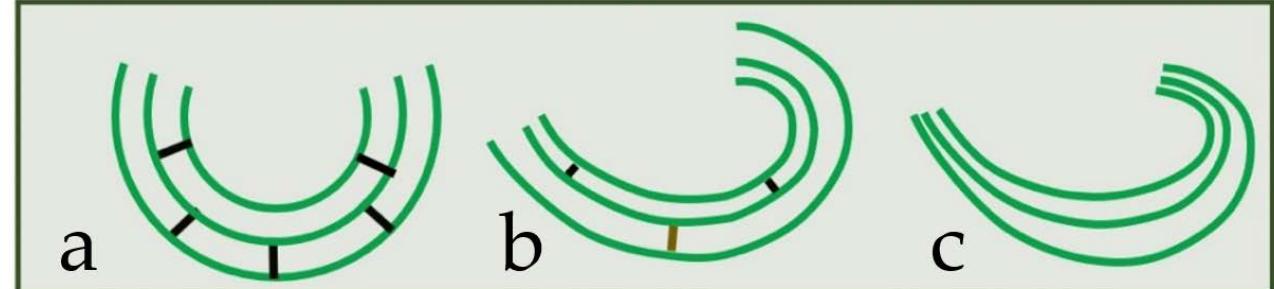
Figure 5. Isometric and equidistant structures in two dimensions. ( a ) shows an isometric arrangement, where the distances of the closest approach between all neighbouring columns are constant and equal. Note that the columns lie in a family of concentric circular arcs. ( b ) shows an equidistant array, where the distances of the closest approach are constant along the length of a pair of neighbouring fibrils, but are not equal throughout a domain. The pattern shown in ( c ) is neither isometric nor equidistant. Redrawn from Atkinson et al. [19].